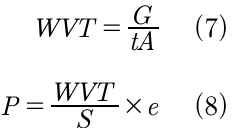
), crystallization temperature (Tc), melting temperature in the c